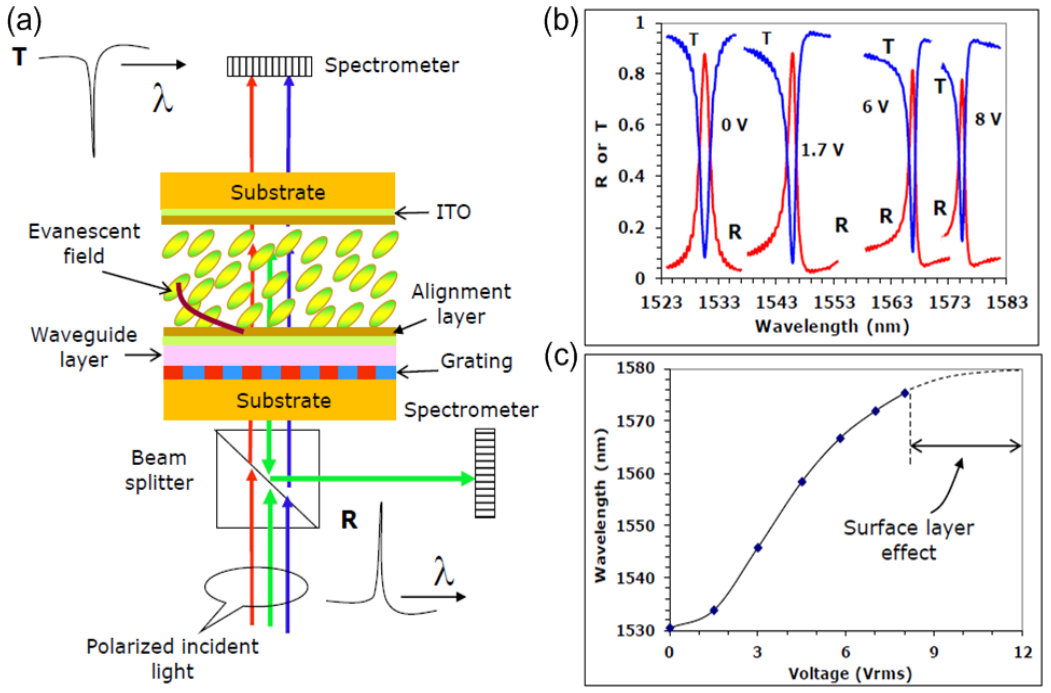
Figure 15. ( a ) Sketch of the hybrid device of reflection filter which can be controlled by nematic LCs. ( b ) Transmitted and reflected spectra at varying voltages. ( c ) Tunability curve of resonance wavelength as a function of voltage. S-shaped profiles can be observed, which means the nanoscale coherence region cannot switch with a fast speed. Reproduced with permission from [121]. Copyright Society of Photographic Instrumentation Engineers (SPIE) and Chinese Optics Letters (COL), 2012.